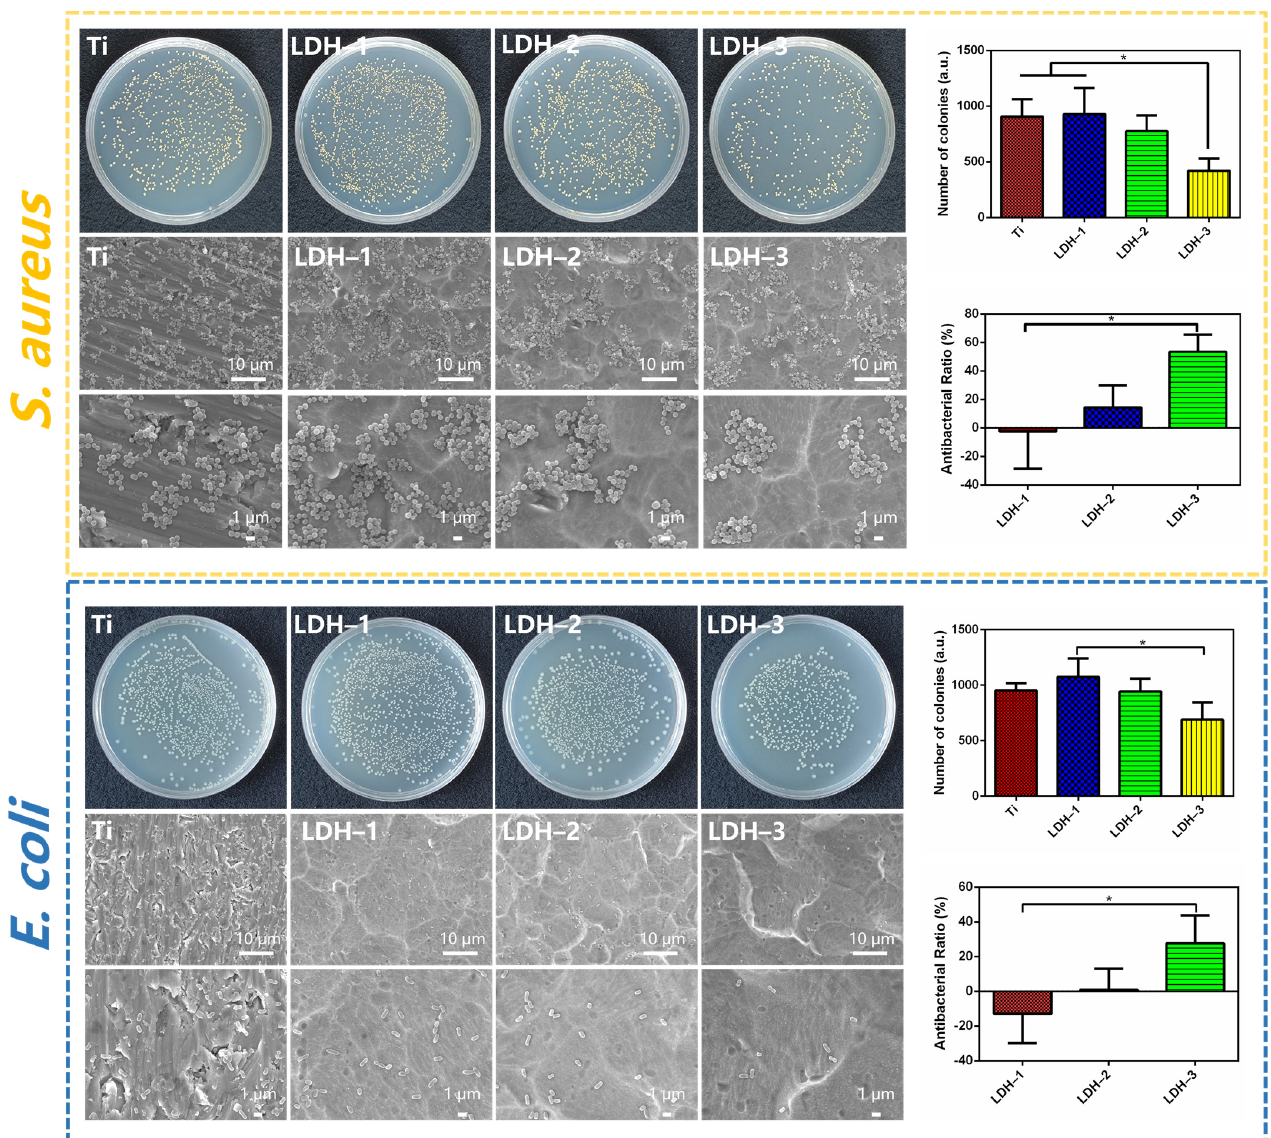
Figure 2. Photographs of colony distributions of S. aureus and E. coli cultured on Ti, LDH − 1, LDH − 2, and LDH − 3 samples; corresponding quantitative analysis and SEM morphology images of S. aureus and E. coli cultured on the surface of Ti, LDH − 1, LDH − 2 and LDH − 3 samples. (* p < 0.05)